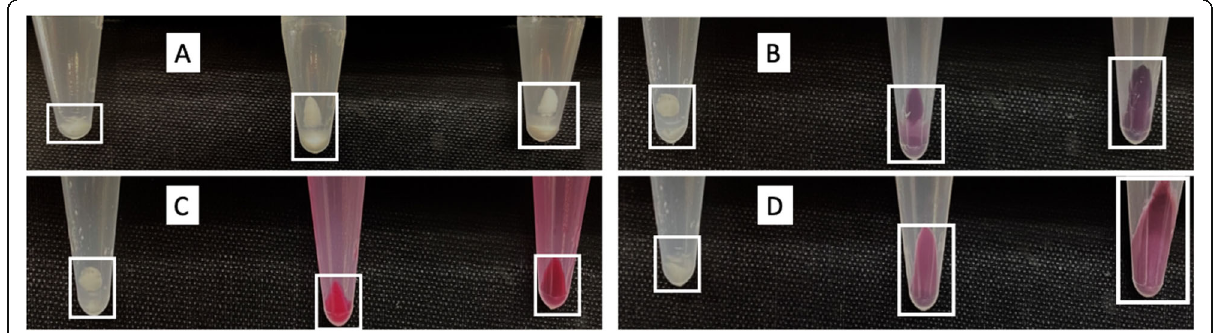
Fig. 8 Image depicting the precipitated fractions (highlighted in boxes) of 7 times diluted, centrifuged dispersions with 1:0 WPI:sucrose and 0% (Left), 0.5% (Center), and 1% bioactives (Right) from pure gallotannin A , Aronia berry extract B , beet extract C , and cranberry extract D . *COLOR USAGE